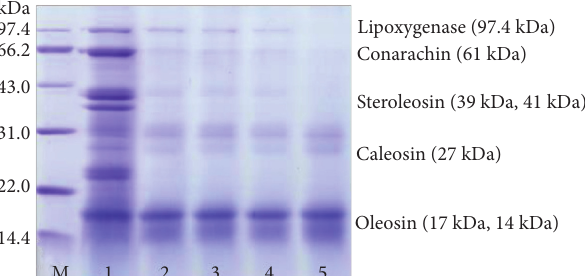
Figure 5: Effects of different pH treatments on the composition of interfacial proteins in peanut oil body (M, 1, 2, 3, 4, and 5 represent marker, pH 6.8-OB, pH 8-OB, pH 9-OB, pH 10-OB, and pH 11-OB,